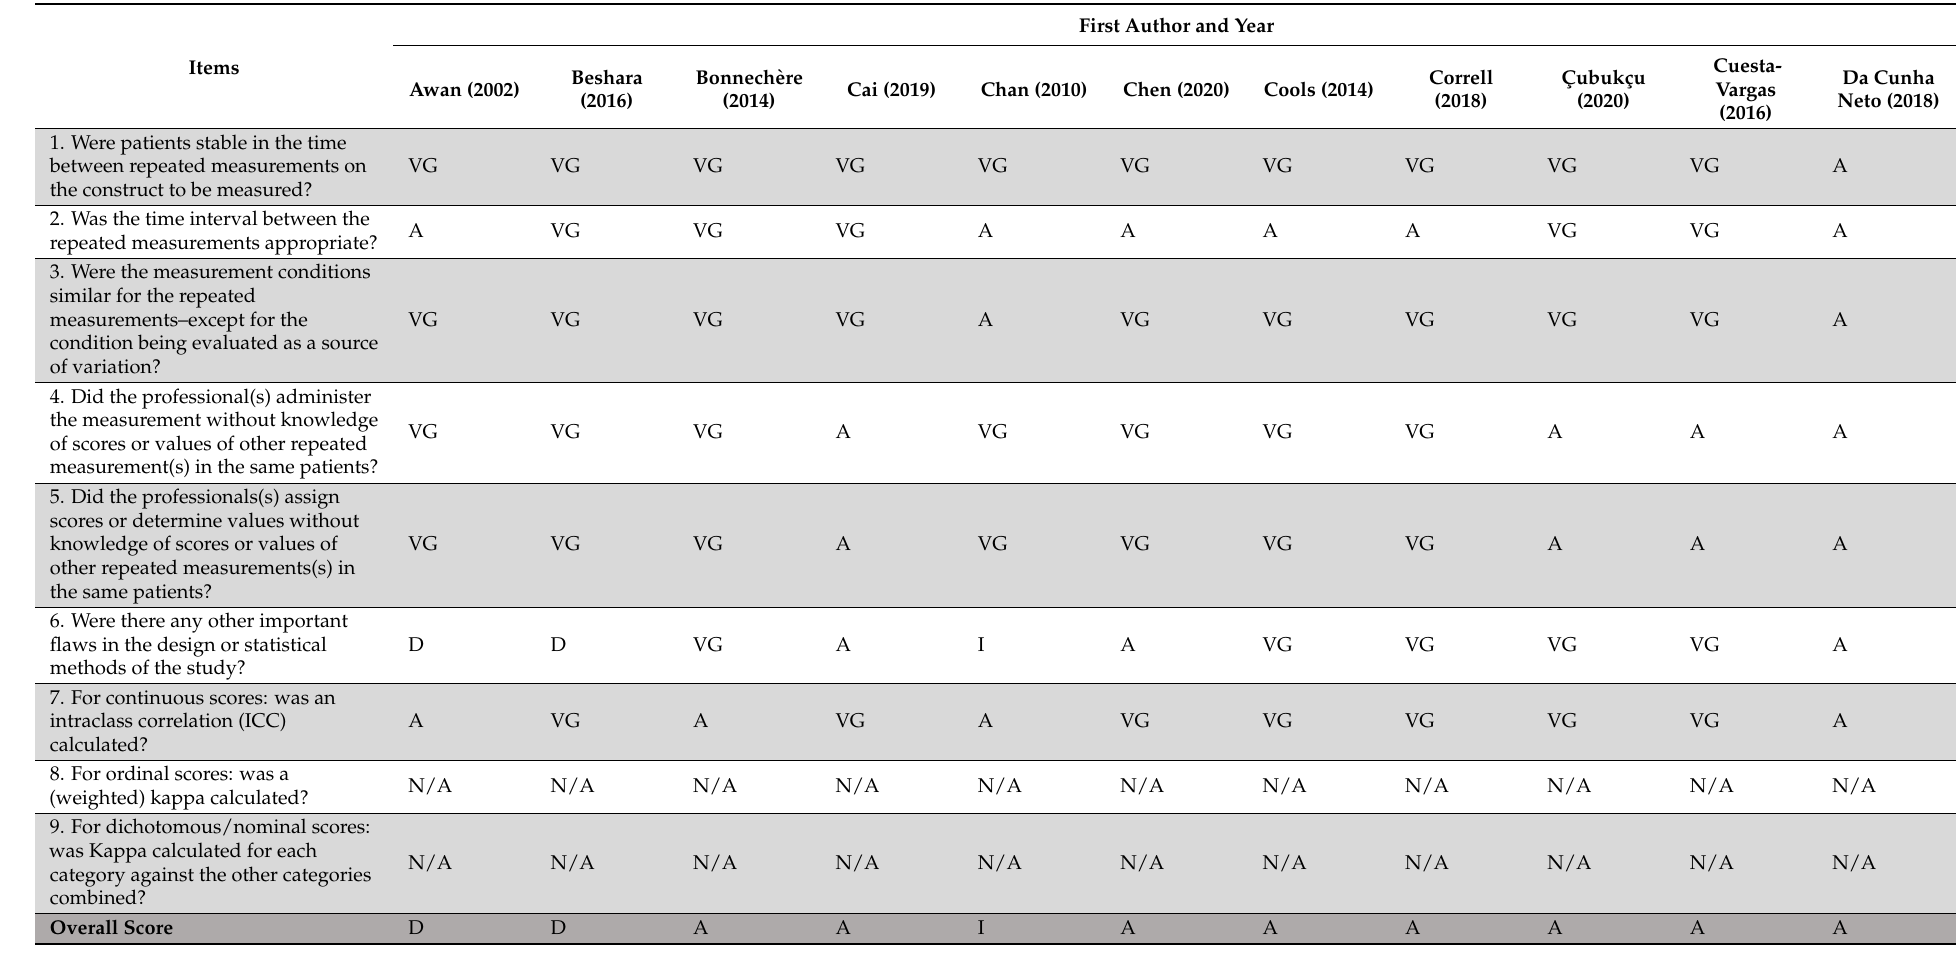
Table 3. Assessment of reliability using the COSMIN standards for studies on reliability